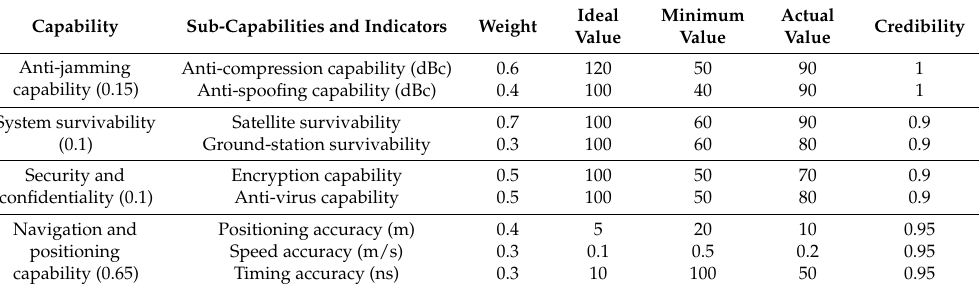
Table 2. Capability